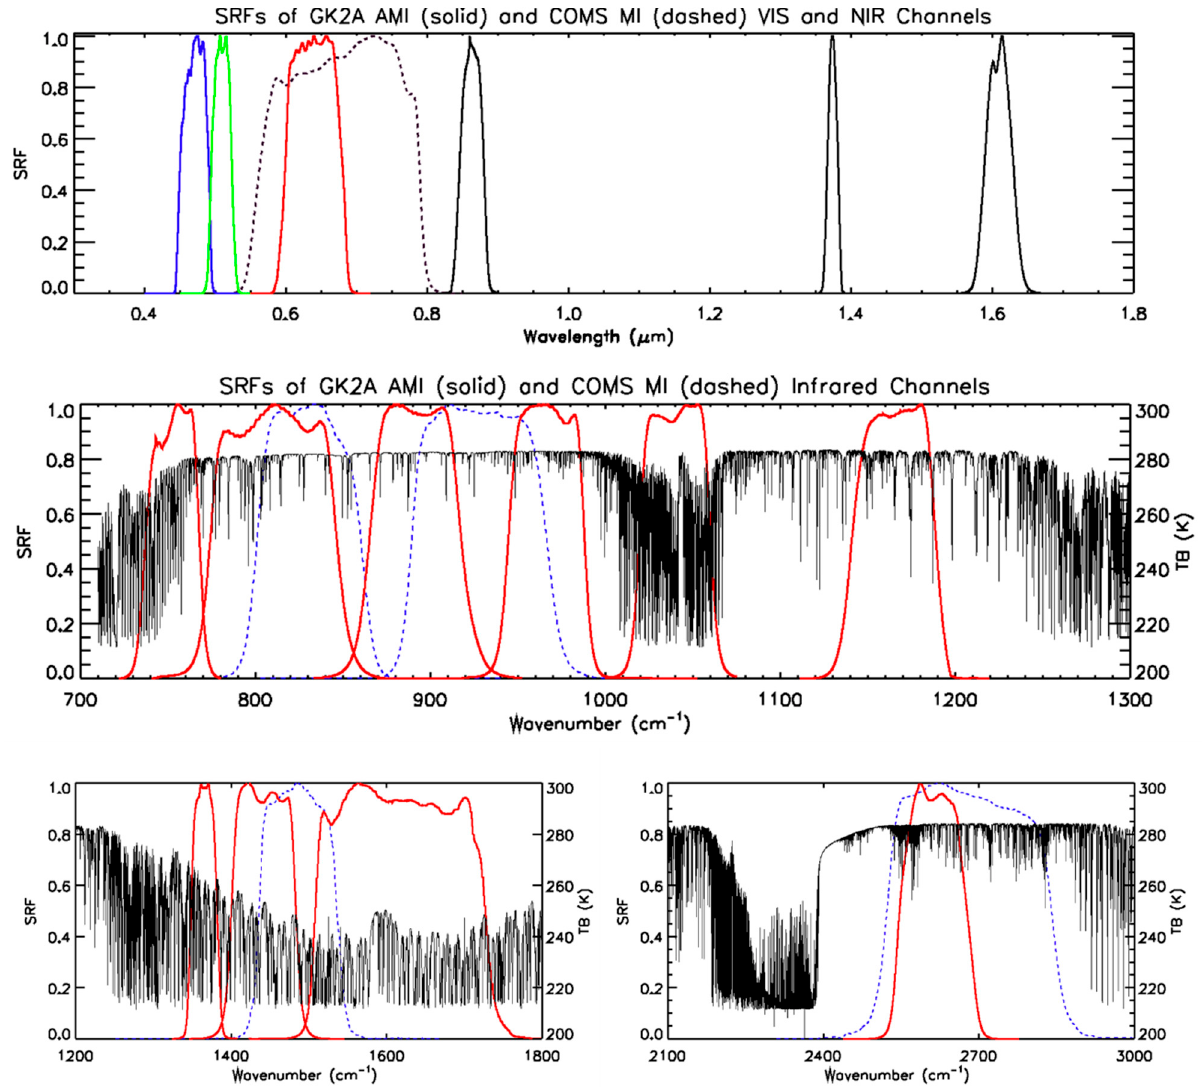
Figure 2. Spectral response functions (SRFs) for visible and near-infrared channels ( top ) and infrared channels ( middle ) and ( bottom ) of the GK2A AMI and Communication, Ocean, and Meteorological Satellite (COMS) Meteorological Imager (MI). The solid and dashed lines in the visible and near-infrared channels represent values for AMI and MI, respectively, and the corresponding red lines and blue dashed lines represent the same in the infrared channels. The black lines in the infrared channels represent the brightness temperatures of up-welling radiances at the top of the atmosphere, as simulated using the radiative transfer model with HITRAN2000 (AER updates) line parameters on the basis of the U.S. standard atmosphere.